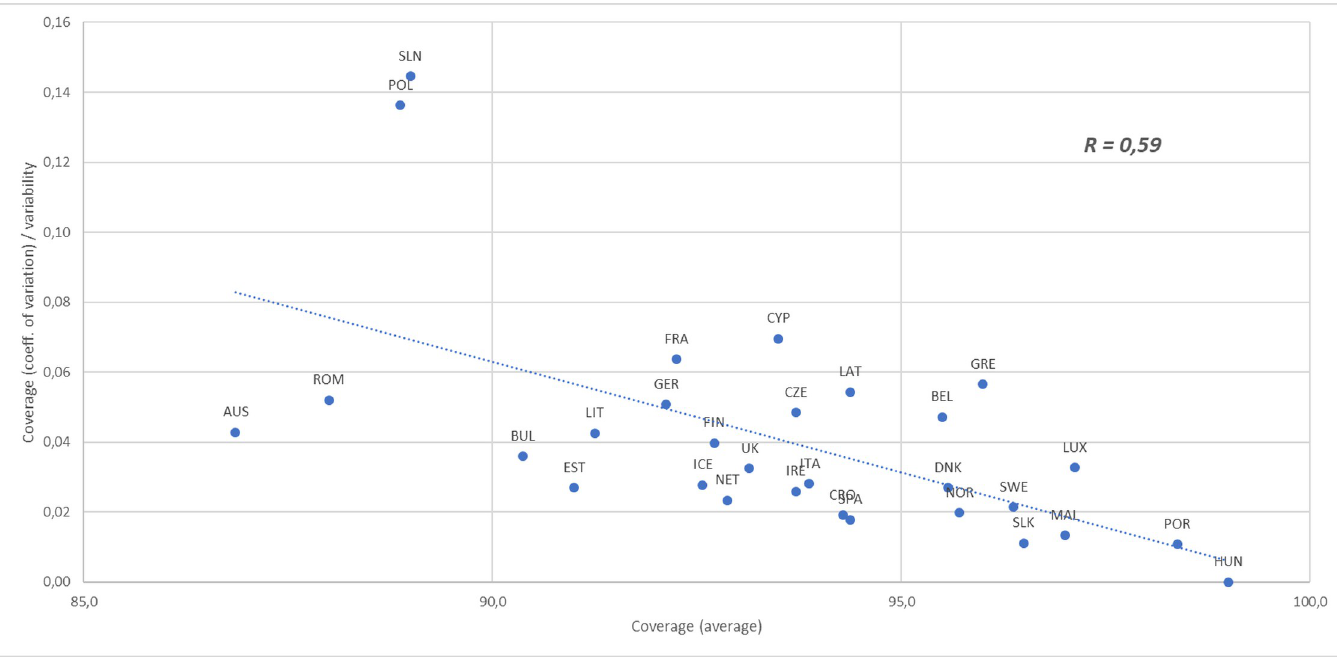
Fig 1. Scatterplot diagram reporting the correlation between the average vaccination coverage and the vaccination coverage variability computed at country level (i.e. inter-country analysis).